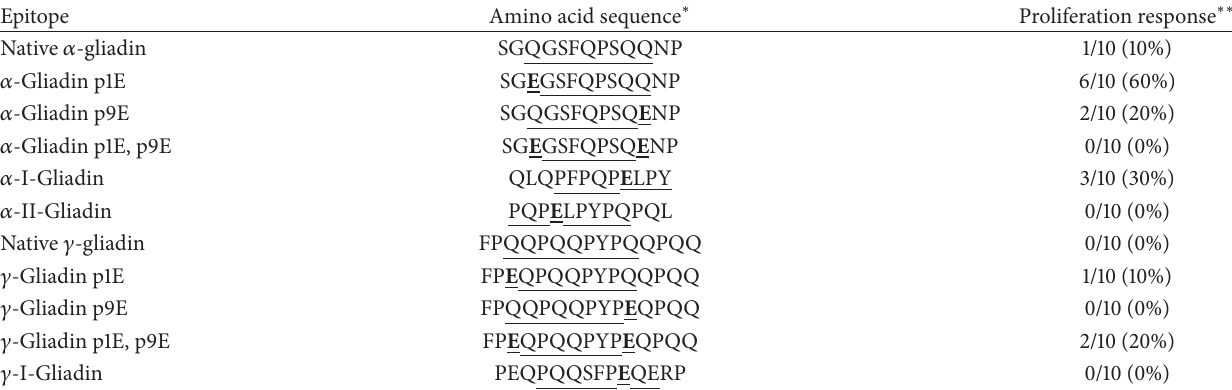
Table 2: Proliferative responses to 𝛼 - and 𝛾 -gliadin epitopes.